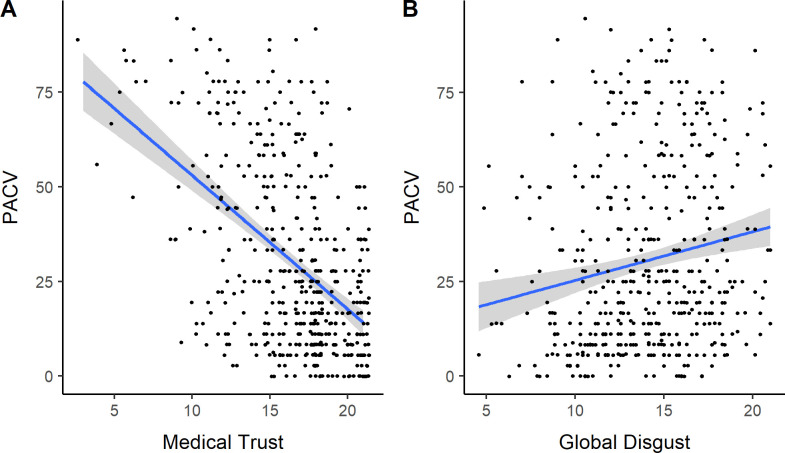
PACV scores over trust in medicine (A) and global disgust sensitivity (B).